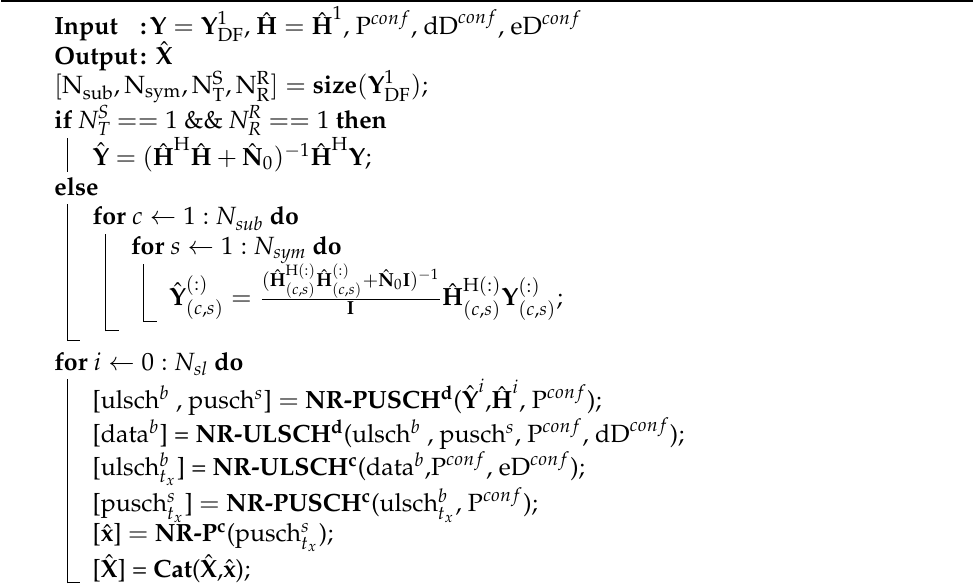
Algorithm 1: Uplink MIMO NR decode-and-encode with MMSE